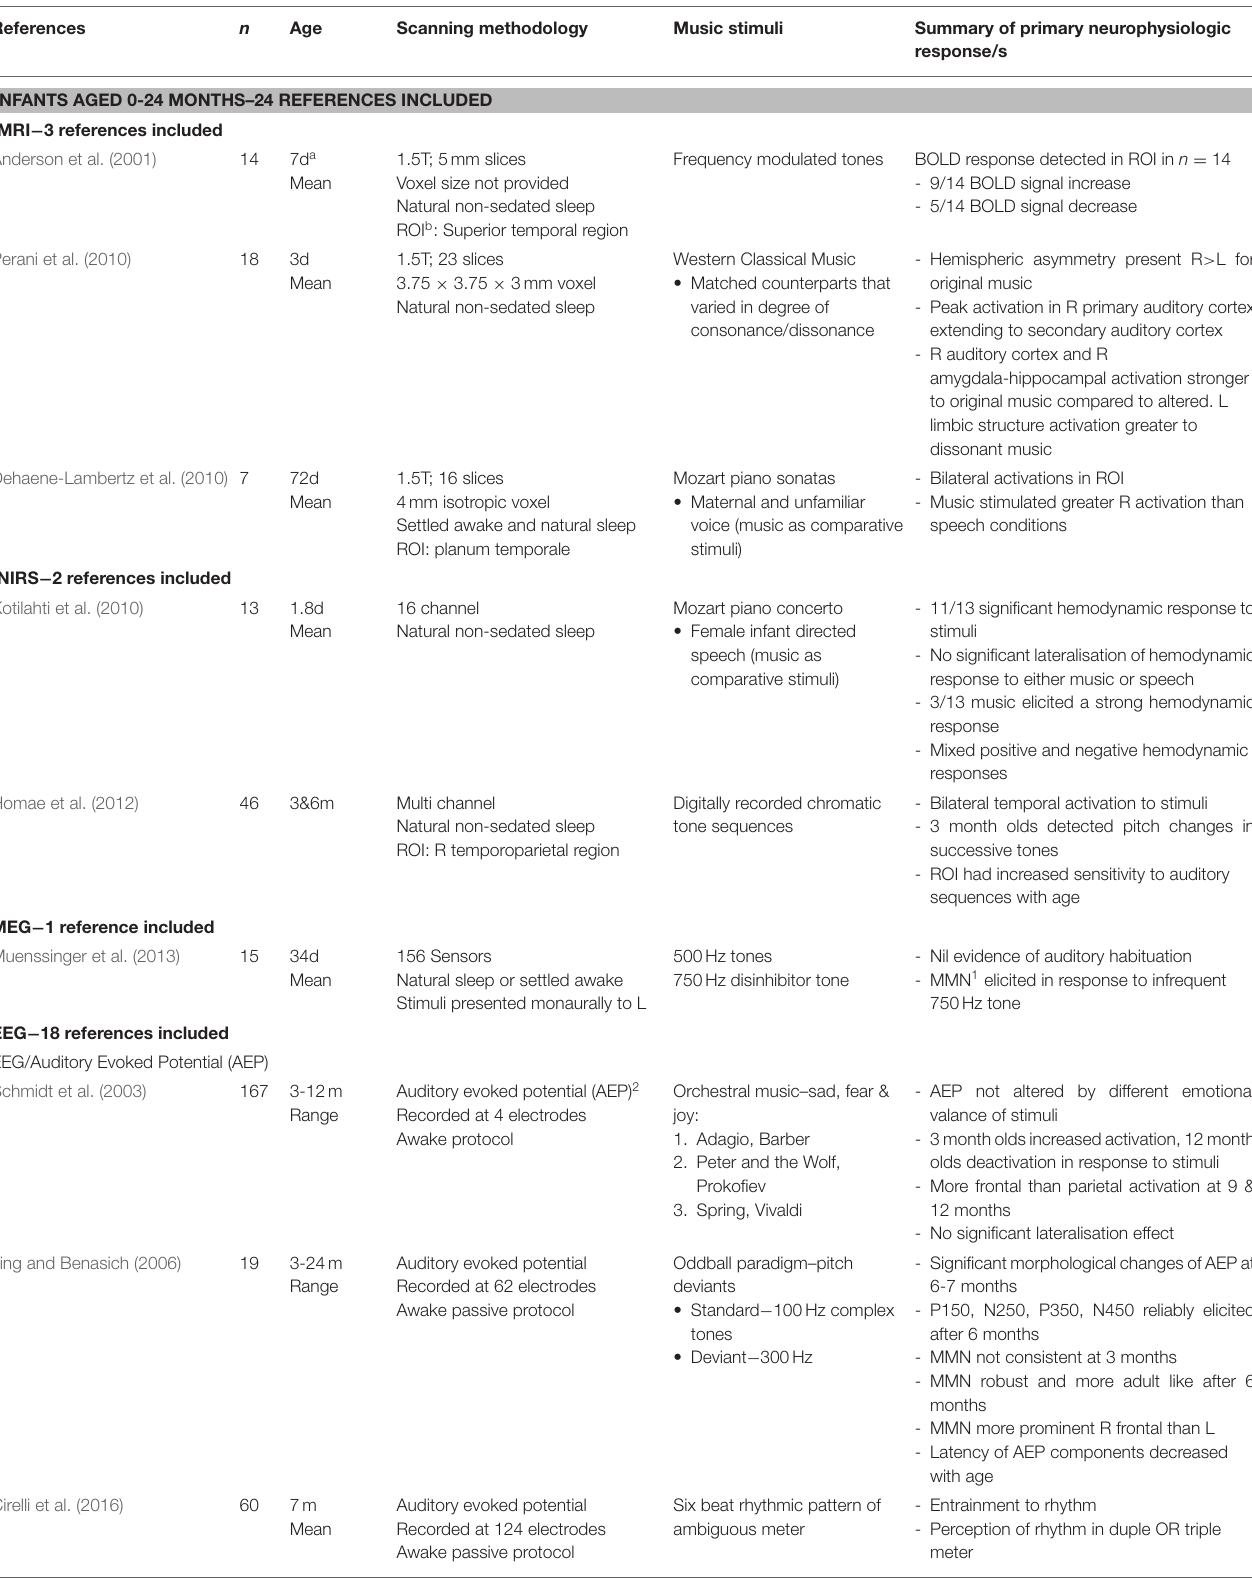
TABLE 1 | Included references summary of results (ordered by year of